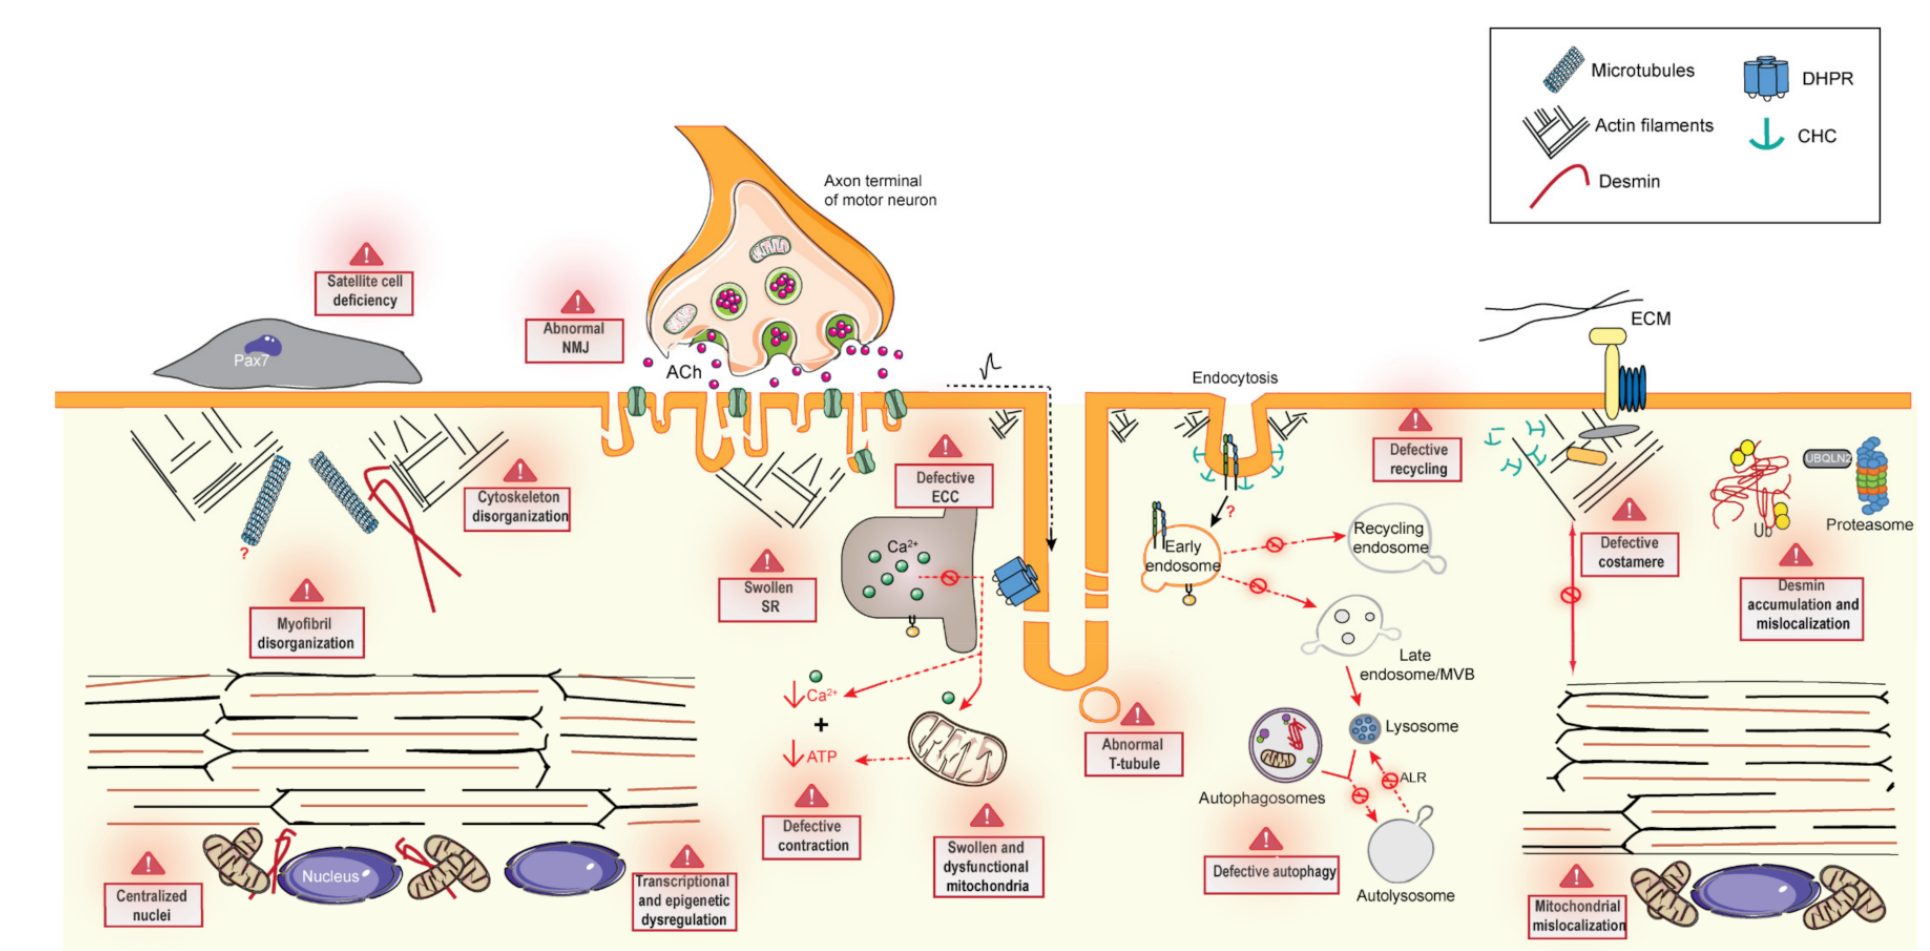
Figure 3. Schematic illustration of pathogenic alterations in skeletal muscle caused by mutations in MTM1, BIN1, DNM2, and RYR1. ECM (extracellular matrix), ALR (autophagic lysosome reformation), SR (sarcoplasmic reticulum), Ub (ubiquitin), NMJ (neuromuscular junction), ECC (excitation-contraction coupling), Ach (acetylcholine), MVB (multivesicular bodies). The figure uses modified images from Servier Medical Art Commons Attribution 3.0 Unported License (http://smart.servier.com, accessed on 29 August